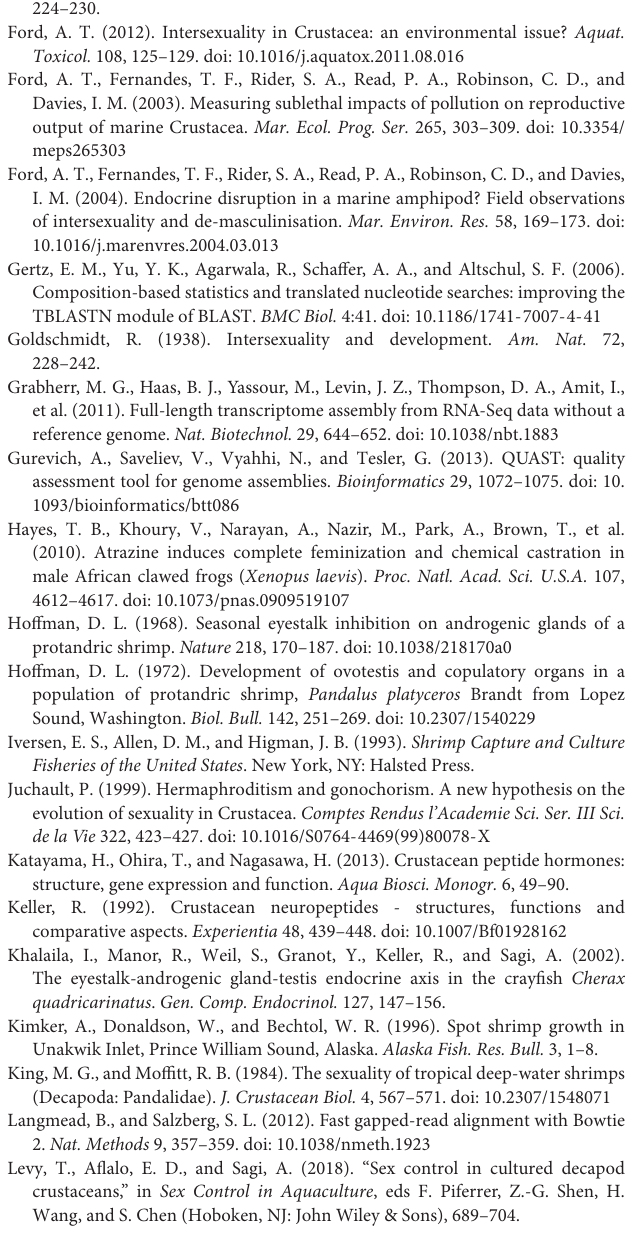
Supplementary Table 6 | Body and eye-specific genes found in the joint reference transcriptome. Read counts in each stage (I, M, YF and MF) as well as Trinotate annotations are given. Supplementary Table 7 | H. inermis homologs to IAG-switch-like proteins in P. platyceros . GenBank accession numbers of the genes in P. platyceros as well as the corresponding transcripts in the H. inermis body transcriptome are